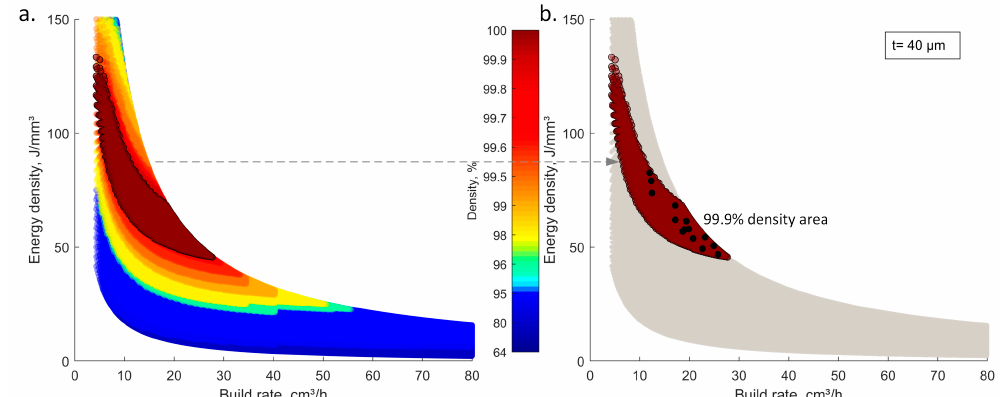
Figure 4. Density processing map for iron: powder ( a ) all densities ( b ) ≥ 99.9% density area; dots identify 14 processing condition sets used for model calibration (see further).